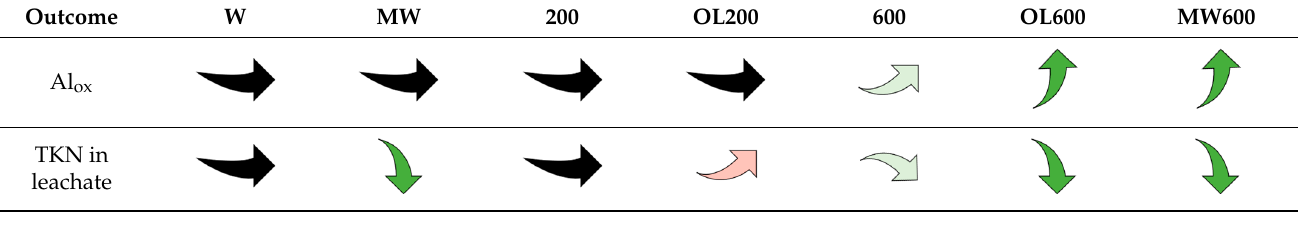
Table 6. Qualitative summary of treatment effects on key outcomes. Upward arrows indicate an increase in the outcome value whereas downward arrows indicate a decrease in the outcome. Green color indicates desirable improvement whereas red color indicates undesirable changes. The direction and color saturation indicate the strength of change. A level black arrow indicates negligible changes.